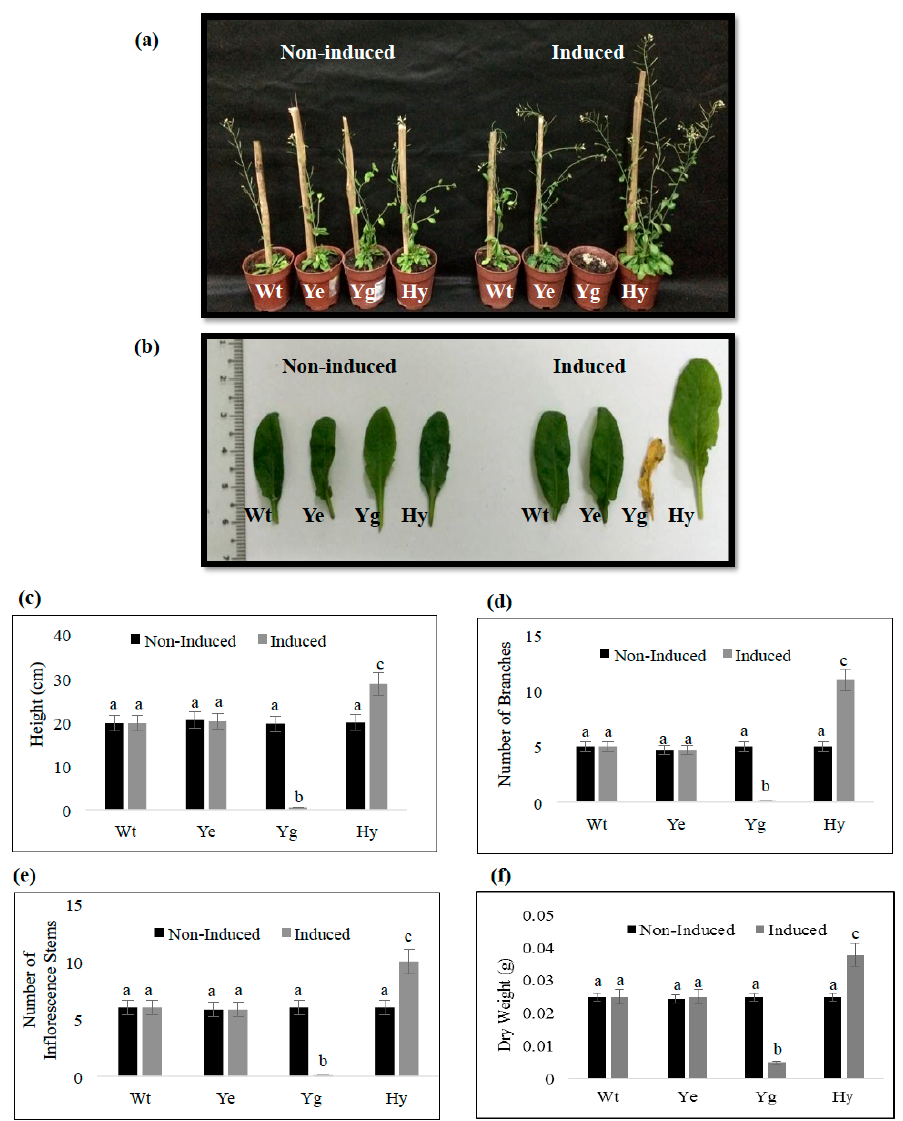
Figure 6. Morphology of the yefM Spn × yoeB Spn -GFP transgenic hybrid and control plants at nine weeks. ( a ) Non-induced and induced plants at nine weeks after planting. Plants were induced with 17- β -estradiol four weeks after planting and were allowed to grow until maturity; ( b ) The seventh leaf of the rosette of the hybrid plants (Hy) as compared to the wild-type (Wt), A. thaliana ( yefM Spn ) (Ye) and A. thaliana ( yoeB Spn -GFP ) (Yg); ( c ) Total height for each plant measured from the soil to the top of the plant; ( d ) Number of branches bearing siliques in each plant; ( e ) Number of inflorescence stems formed in each plant; and ( f ) Dry weight of each plant. Wt: wild-type A. thaliana ; Ye: transgenic A. thaliana ( yefM Spn ); Yg: transgenic A. thaliana ( yoeB Spn -GFP ); Hy: transgenic A. thaliana ( yefM Spn × yoeB Spn -GFP ) hybrid. The data in ( c – f ) are shown as the mean ± standard deviation ( n = 20). Different letters above the bars indicate significantly different means ( p < 0.05, as analyzed by one-way ANOVA (Tukey used as the post hoc test)).